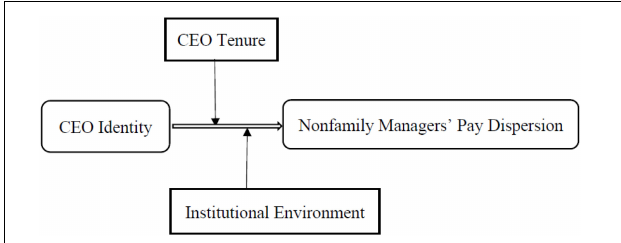
FIGURE 1 | The theoretical